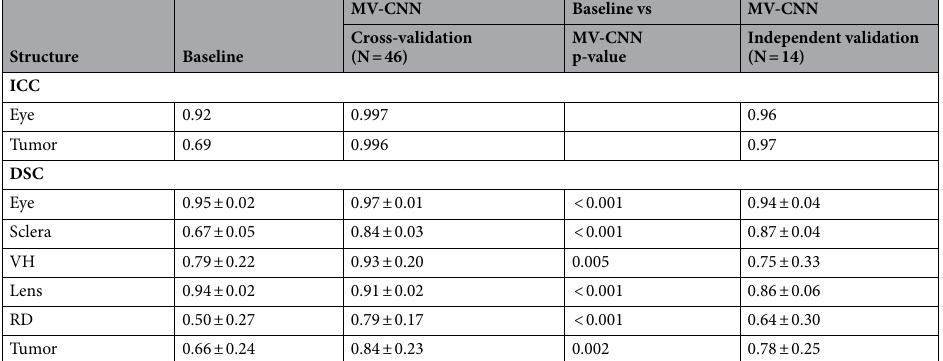
Table 1. Overview of volumetric and spatial performance of the baseline and the proposed multi-view convolutional neural network models, and results of the Wilcoxon signed rank test comparing baseline with MV-CNN DSC. P-values were corrected for multiple comparisons. Small, medium and large columns refer to tumor size subgroups. ICC intra-class correlation; DSC dice similarity coefficient; MV-CNN multi-view convolutional neural network; VH vitreous humour; RD retinal